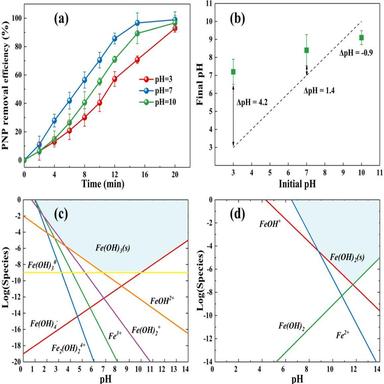
PNP removal efficiency of the electrocoagulation system at different initial pH (a), the final pH of the system (b), and the distribution of Fe3+ (c) and Fe2+ (d) species in the aqueous solution at different pH values.